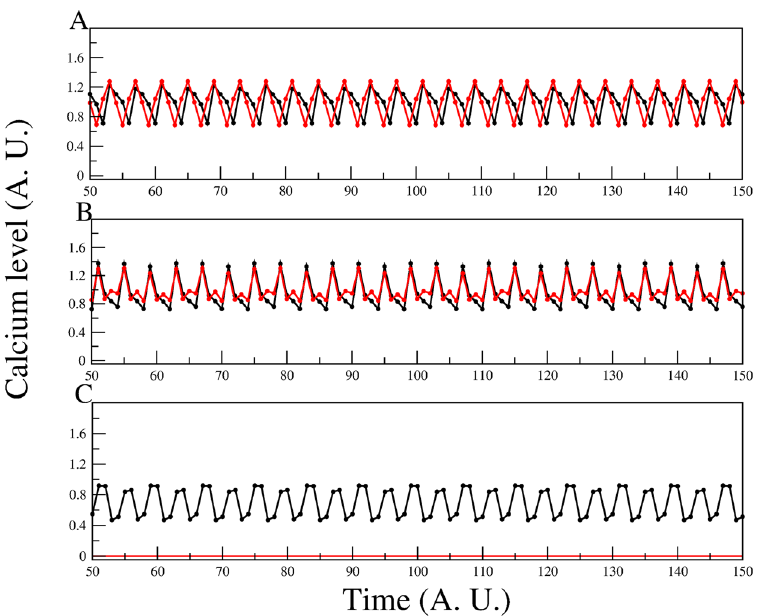
Figure 5. [ Ca 2 + ] i dynamics of the network deleting the pH node for the three models. In panel A for Model-I calcium dynamics, with all nodes present (black) and without the pH node (red), notice that there is hardly any difference in the level of calcium between the two situations. A similar situation is present in panel B for Model-II. The case of Model-III is shown in panel C, the calcium fluctuations completely disappear in the absence of pH, this is so, because the pH directly controls the CatSper dynamics.